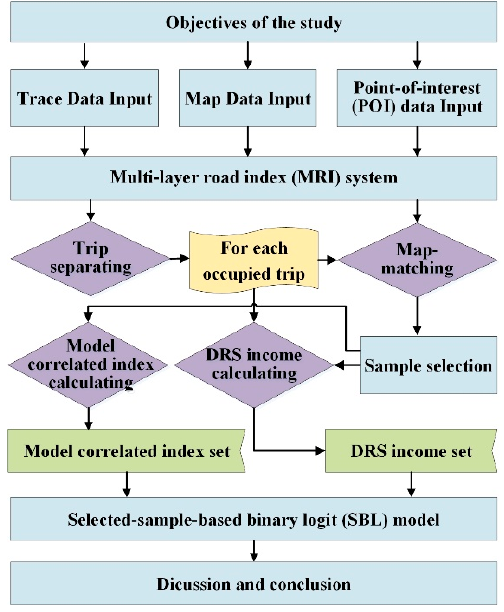
Figure 1. Study methodology flow chart.